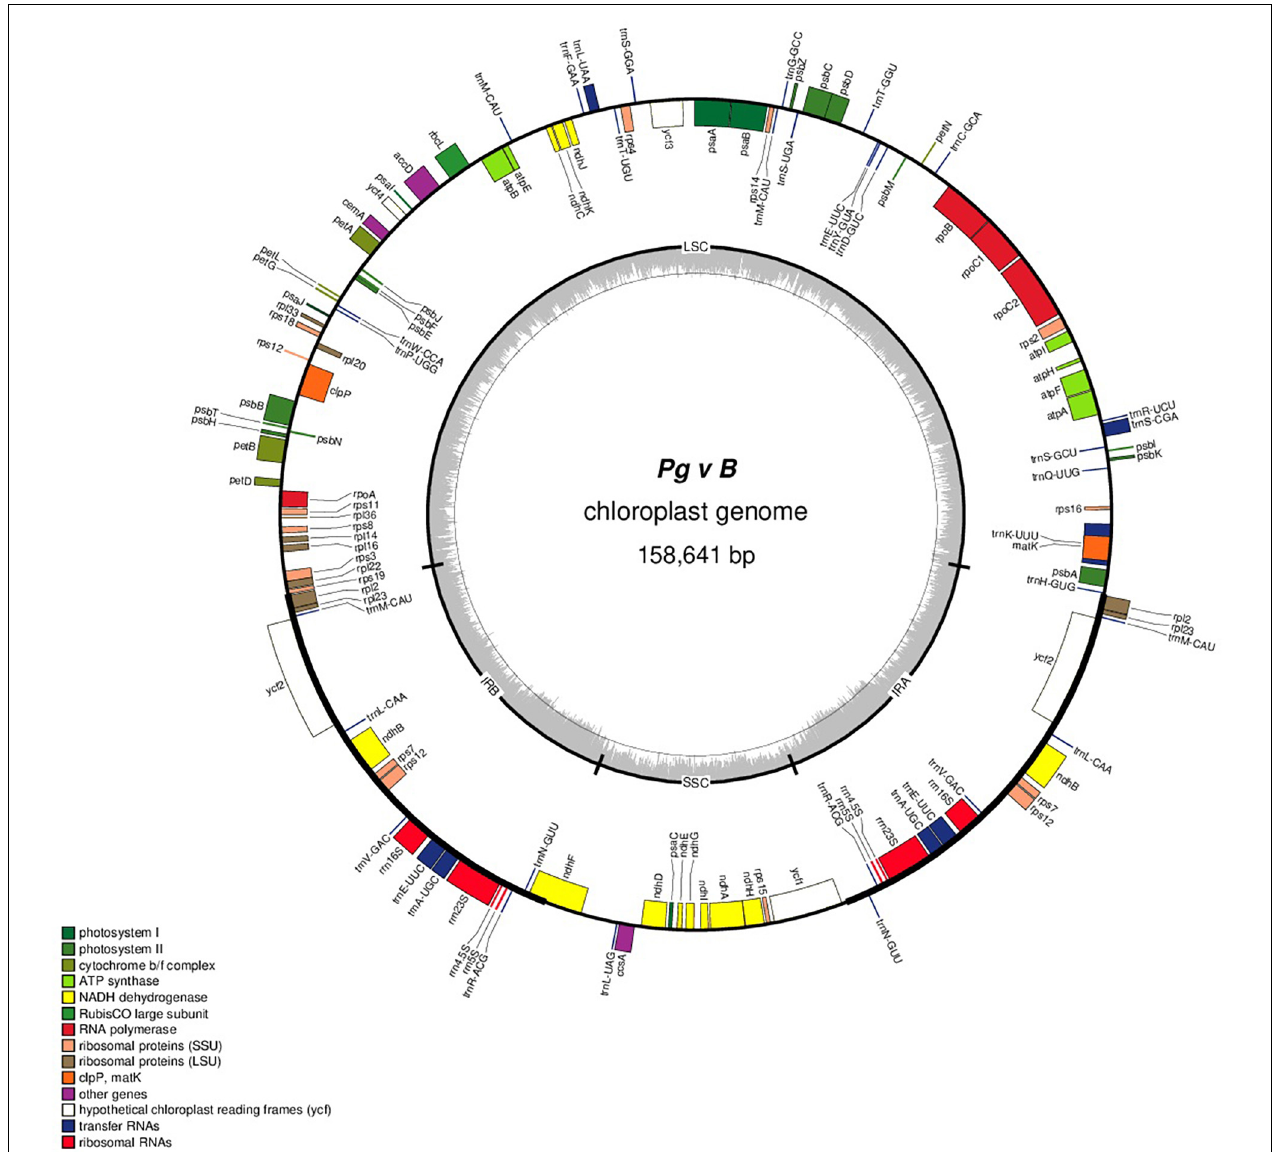
FIGURE 1 | Genome map of the “Bhagawa” cp genome: The thick line in the outer ring indicates the extent of inverted repeat (IR) (IRA and IRB) regions. Genes drawn inside the circle are transcribed clockwise, and those outside are transcribed counter clockwise. Genes belonging to different functional groups are color coded. The dark gray in the inner circle corresponds to the GC content, and the light gray corresponds to the AT